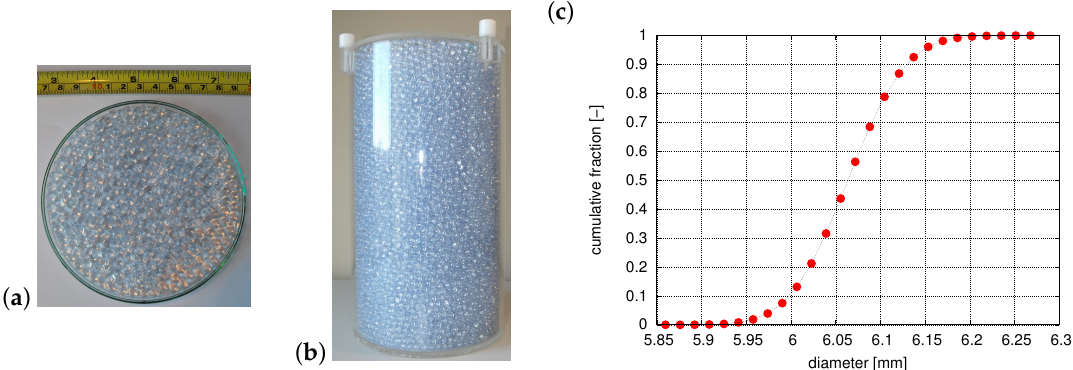
Figure 2. Glass marbles ( a ), a bed sample ( b ), and a cumulative discrete distribution function consisting of 25 fractions ( c